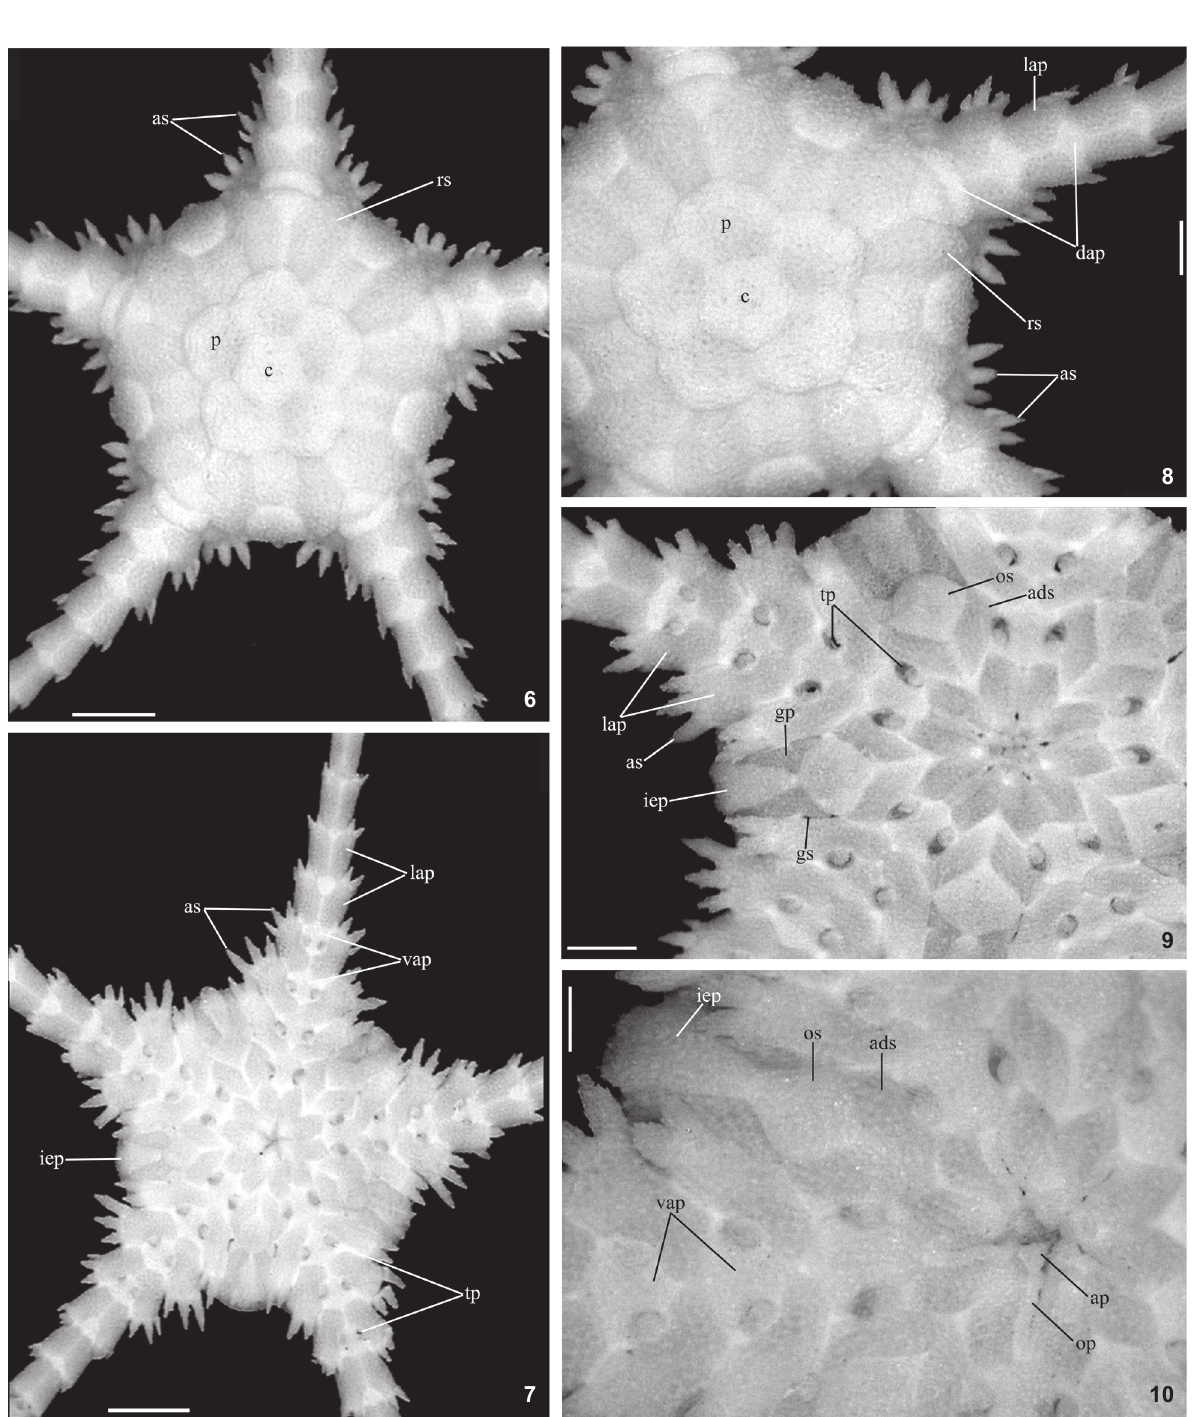
Figures 6-10. Ophiomisidium pulchellum : (6) dorsal view; (7) ventral view; (8) detail of the disk and dorsal arm; (9) detail of the ventral region (shields and arm); (10) detail of the oral region. (ap) Apical papilla, (ads) adoral shield, (as) arm spine, (c) centrodorsal plate, (dap) dorsal arm plate, (gp) genital plate, (gs) genital slip, (iep) interradial elongated plate, (lap) lateral arm plate, (op) oral papilla, (os) oral shield, (p) primary plate, (rs) radial shield, (tp) tentacle pore, (vap) ventral arm plate. Scale bars: 6-7 = 1 mm, 8-9 = 0.5 mm, 10 = 0.3